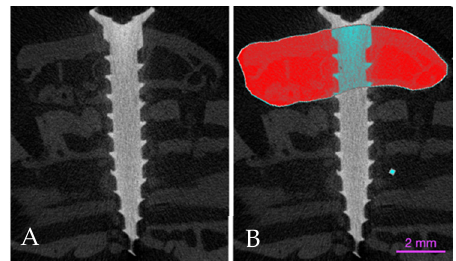
Figure 2. ( A ) Augmented site. ( B ) Volume analyzed